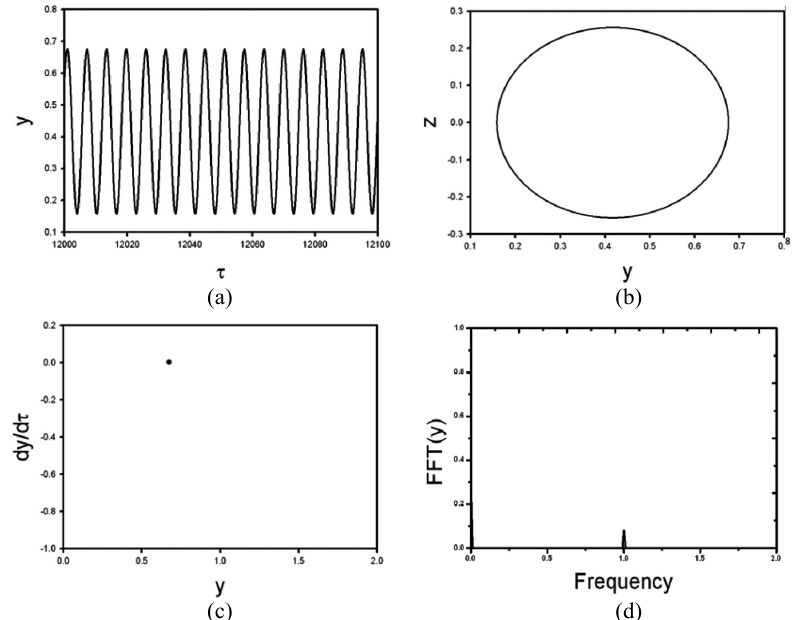
Fig. 9. Dynamic characteristic of the y-displacement of the mid-span point with ω = 200 rad/s. (a) Time history; (b) Orbital trajectory; (c) Poincar´e section; (d) FFT.